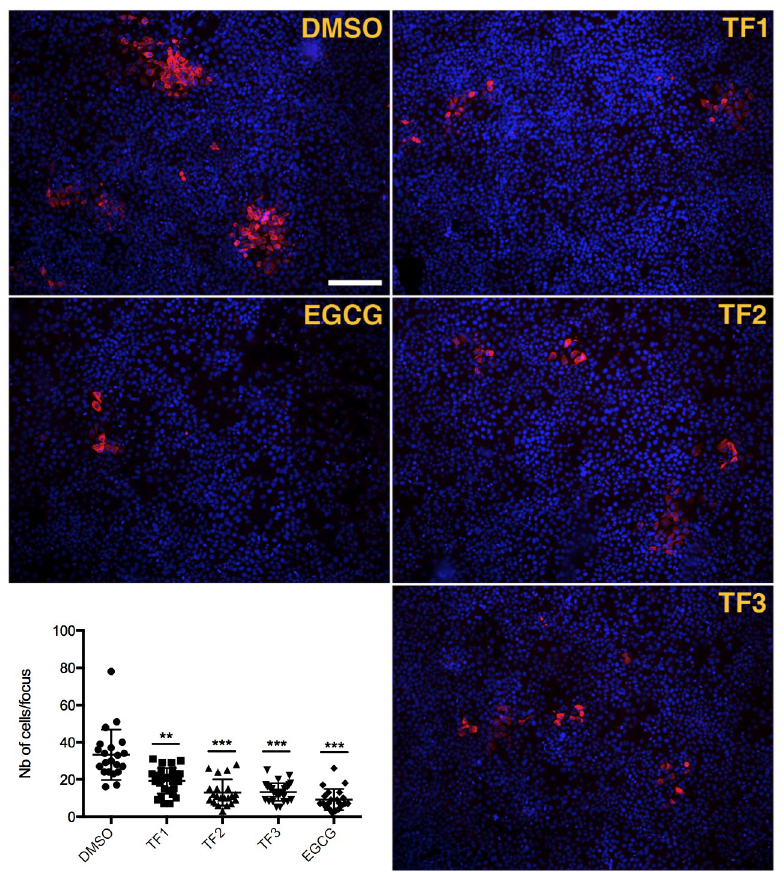
Fig 6. Theaflavins inhibit cell-to-cell spread. Huh-7 cells were inoculated with HCV JFH-1 for 2 h. Inoculum was replaced by medium containing mAb 3/11 neutralizing antibody to prevent extracellular propagation. Theaflavins at 25 μ g/ml or EGCG at 50 μ M were added in the medium after inoculation. Cells were fixed 72 h after infection and subjected to immunofluorescence detection of E1 HCV envelope protein revealed with a Cy3-conjugated goat anti- mouse secondary antibody (red). Nuclei were stained with DAPI (blue). Representative images of each condition are shown. Graph represents the number of cells/focus of 3 independent fields of three independent wells. Error bars represent SD. Data are representative of 3 independent experiments. Statistical analysis were performed with the Kruskal Wallis nonparametric test followed by a Dunn’s multicomparison post hoc test. �� , P = 0.009; ��� , P < 0.0001.